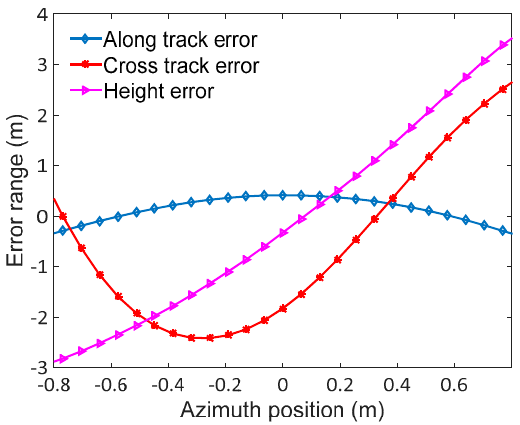
Figure 5. Trajectory deviations for simulation.